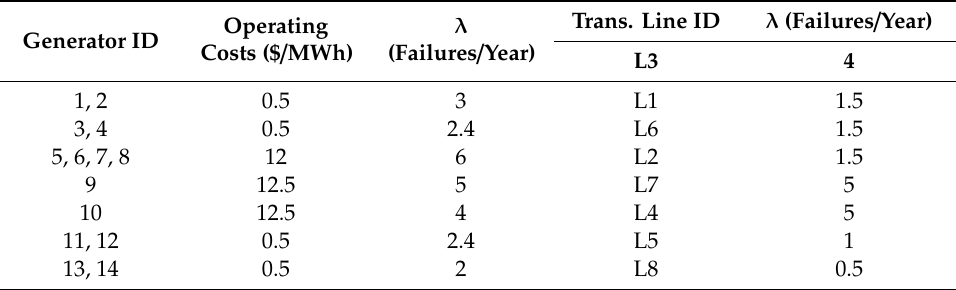
Figure 5. Load data used for different load points in per unit.